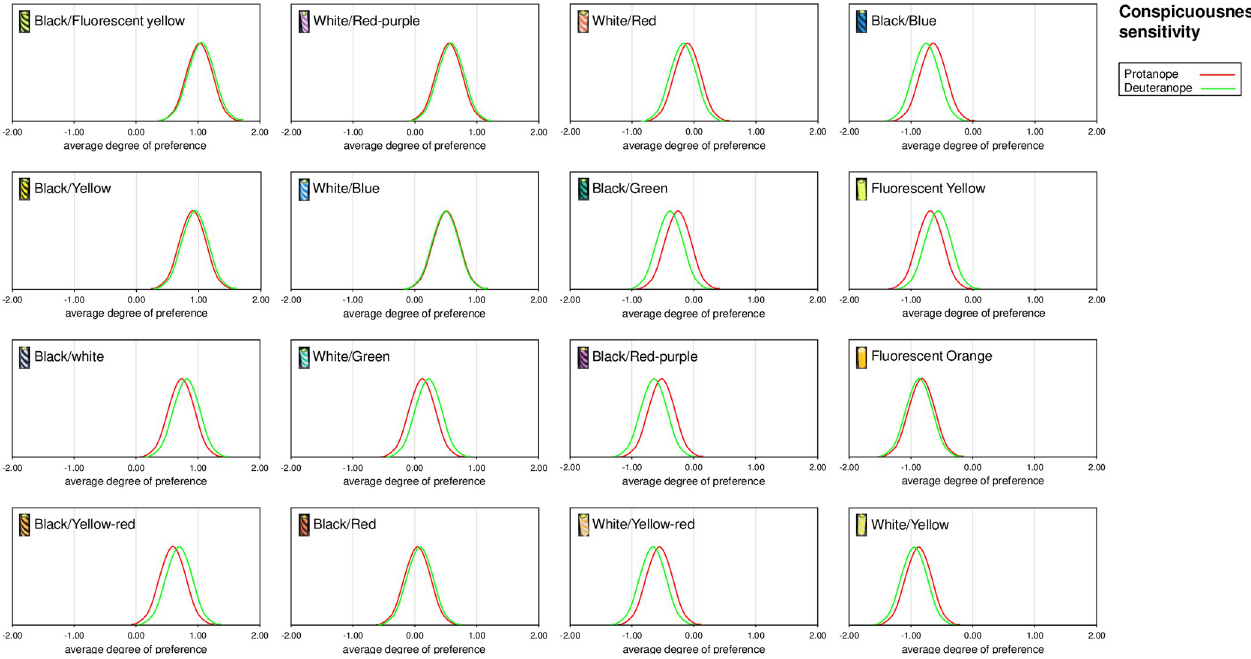
Fig 7. Bell curve of average degree of preference (conspicuousness sensitivity) for protanope and deuteranope. The average degree of preference for the sense of conspicuousness for protanope and deuteranope is shown in a standard normal distribution for each sample. The bell curves overlap in almost all samples in the same way, with comparable visibility.